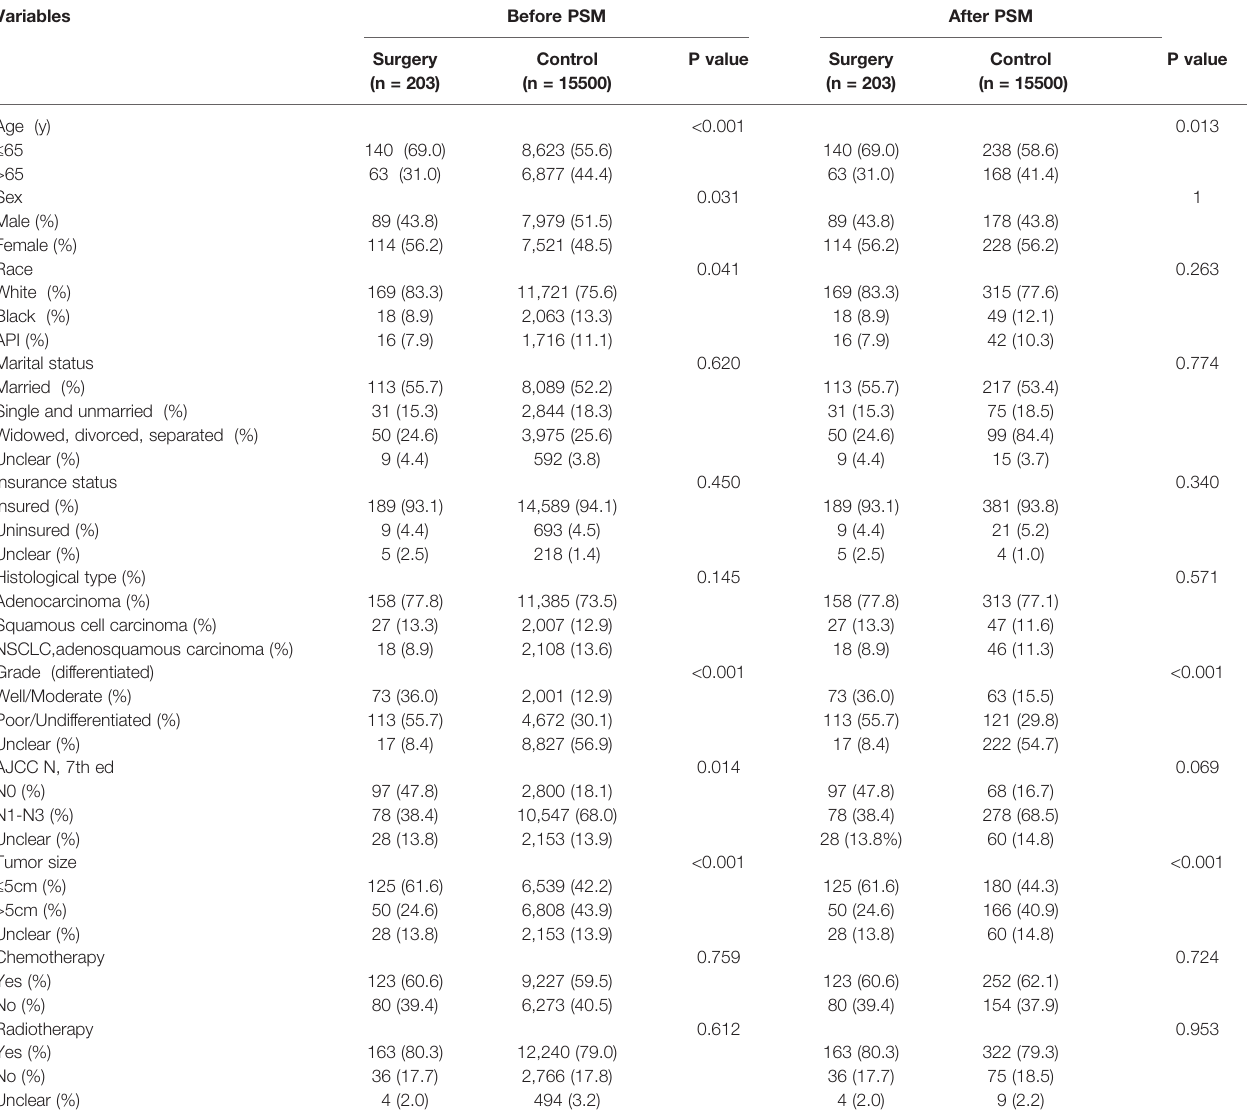
TABLE 1 | Summary characteristics of the overall sample strati fi ed by surgery treatment before and after propensity score matching.